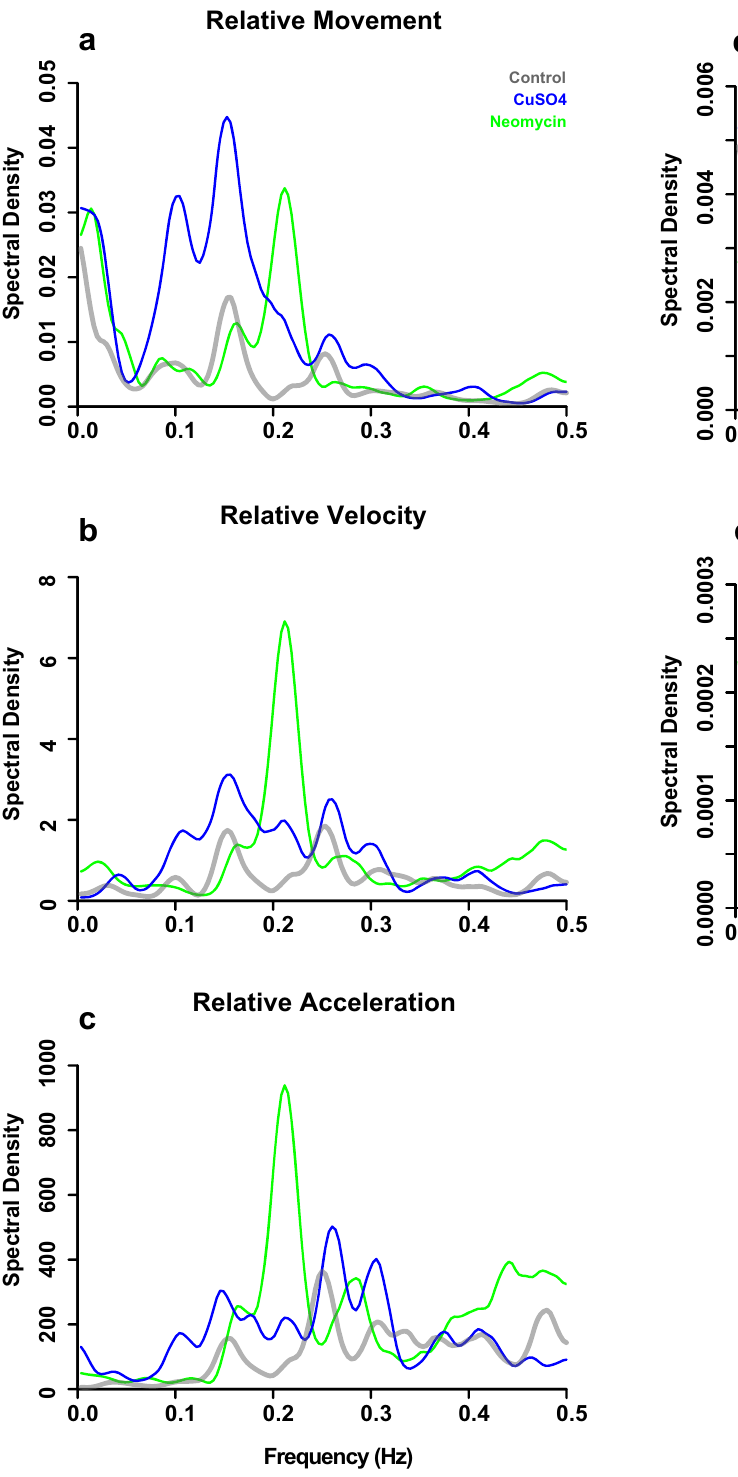
and Supplementary Table 11). The rheotaxis pro fi le of control fi sh was such that the relative timing and direction of changes in mean body angle depended upon the time derivative of the linear movement, but changes angular variance were consistent across all linear movements. For example, intact fi sh tended to change their mean body angle to the left of fl ow before a large change in relative movement (Fig. 9a), to the right of fl ow simultaneous with changes in velocity (Fig. 9c), and to the left of fl ow after changes